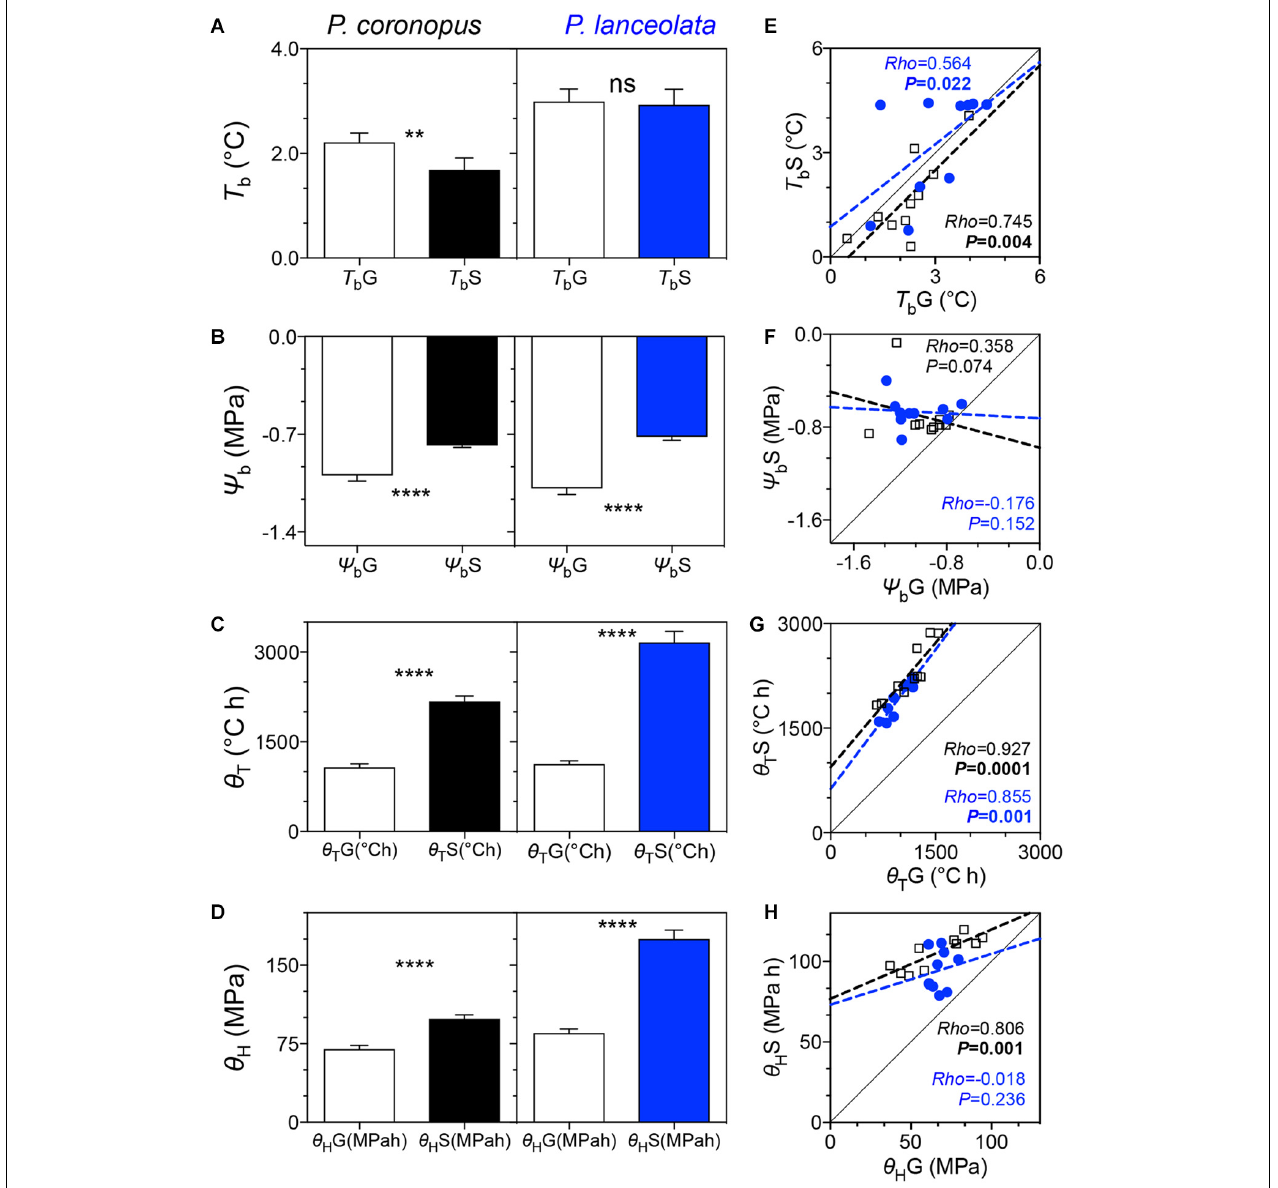
FIGURE 2 | Comparison of base temperature, base water potential, thermal time, hydrotime, and respective linear traits correlations for germination and normal seedling development for 10 accessions of P. coronopus (black) and P. lanceolata (blue): (A) – germination base temperature ( T b G) and normal seedling development base temperature ( T b S); (B) – germination base water potential ( (cid:57) b G) and normal seedling development base water potential ( (cid:57) b S); (C) – germination thermal time ( θ T G) and normal seedling development thermal time; (D) – germination hydrotime ( θ H G) and normal seedling development hydrotime ( θ H S). Linear regressions of the base temperatures for germination ( T b G) against the base temperatures for normal seedling development ( T b S) (E) , base water potential for germination ( (cid:57) b G) against the base water potential for normal seedling development ( (cid:57) b S) (F) , germination thermal time ( θ T G) against the normal seedling development thermal time ( θ T S) (G) , and germination hydrotime ( θ H G) against the normal seedling development hydrotime ( θ H S) (H) . Histograms indicate mean ± SEM of two-way ANOVA test comparing the different traits. Asterisks denote the significant difference of p -values where: ** p = 0.01; **** p = 0.0001; ns, non-significant at α = 0.05. The scatterplot colors represent the mean values of three replicates by species